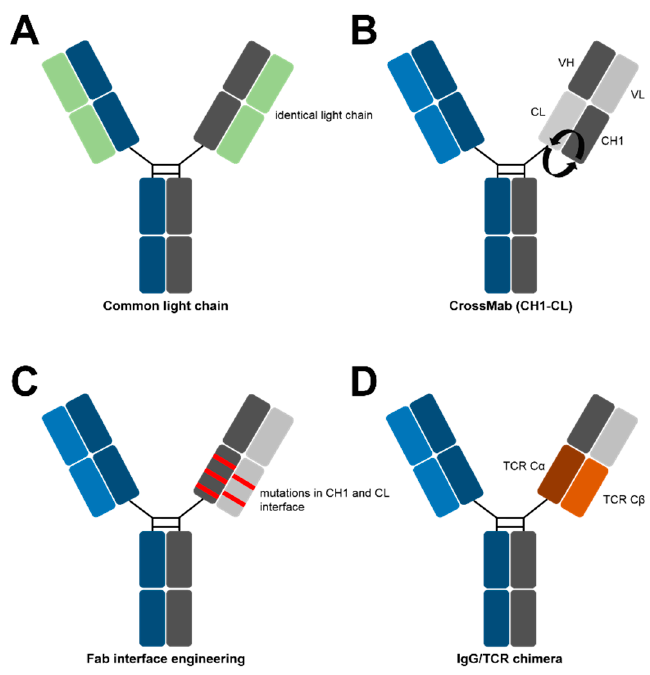
Figure 3. Methods for cognate light chain pairing in IgG-like bsAbs.